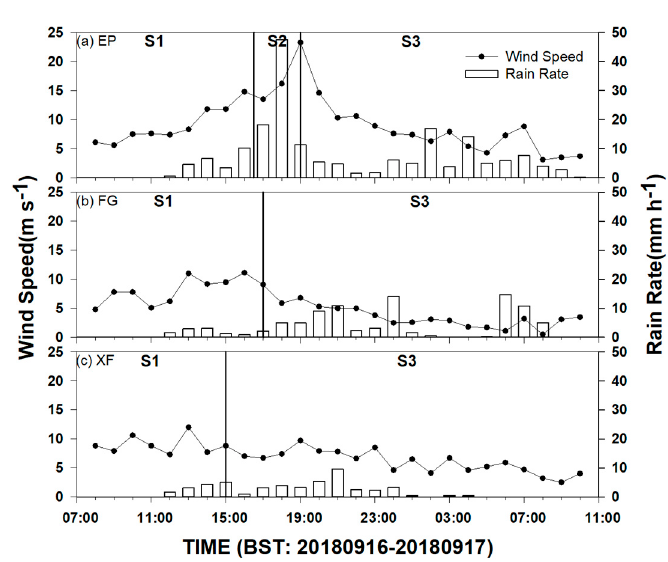
Figure 4. The temporal variabilities of the instantaneous wind speed and hourly rain rate obtained from the National Ground Observation Station of China at the ( a ) EP, ( b ) FG, and ( c ) XF sites.